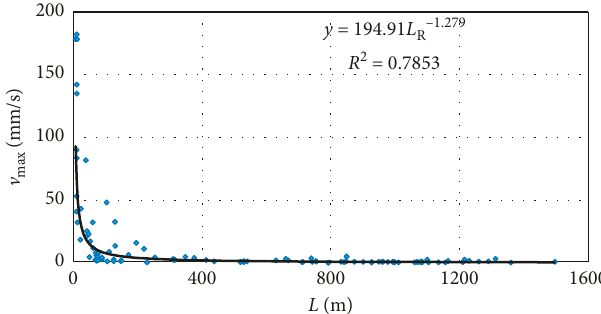
Figure 2: Analysis of velocity spreading in 8 deposits.